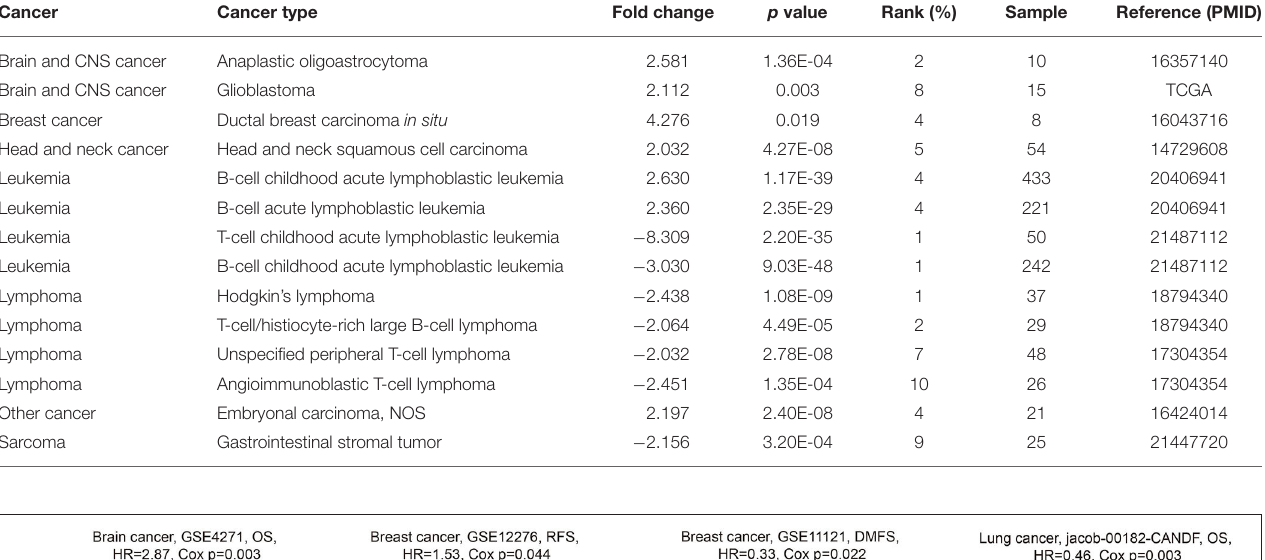
TABLE 1 | The expression of protein kinase R (PKR)-like endoplasmic reticulum kinase (PERK) mRNA between the pan-cancer samples and normal samples in the Oncomine database. Cancer